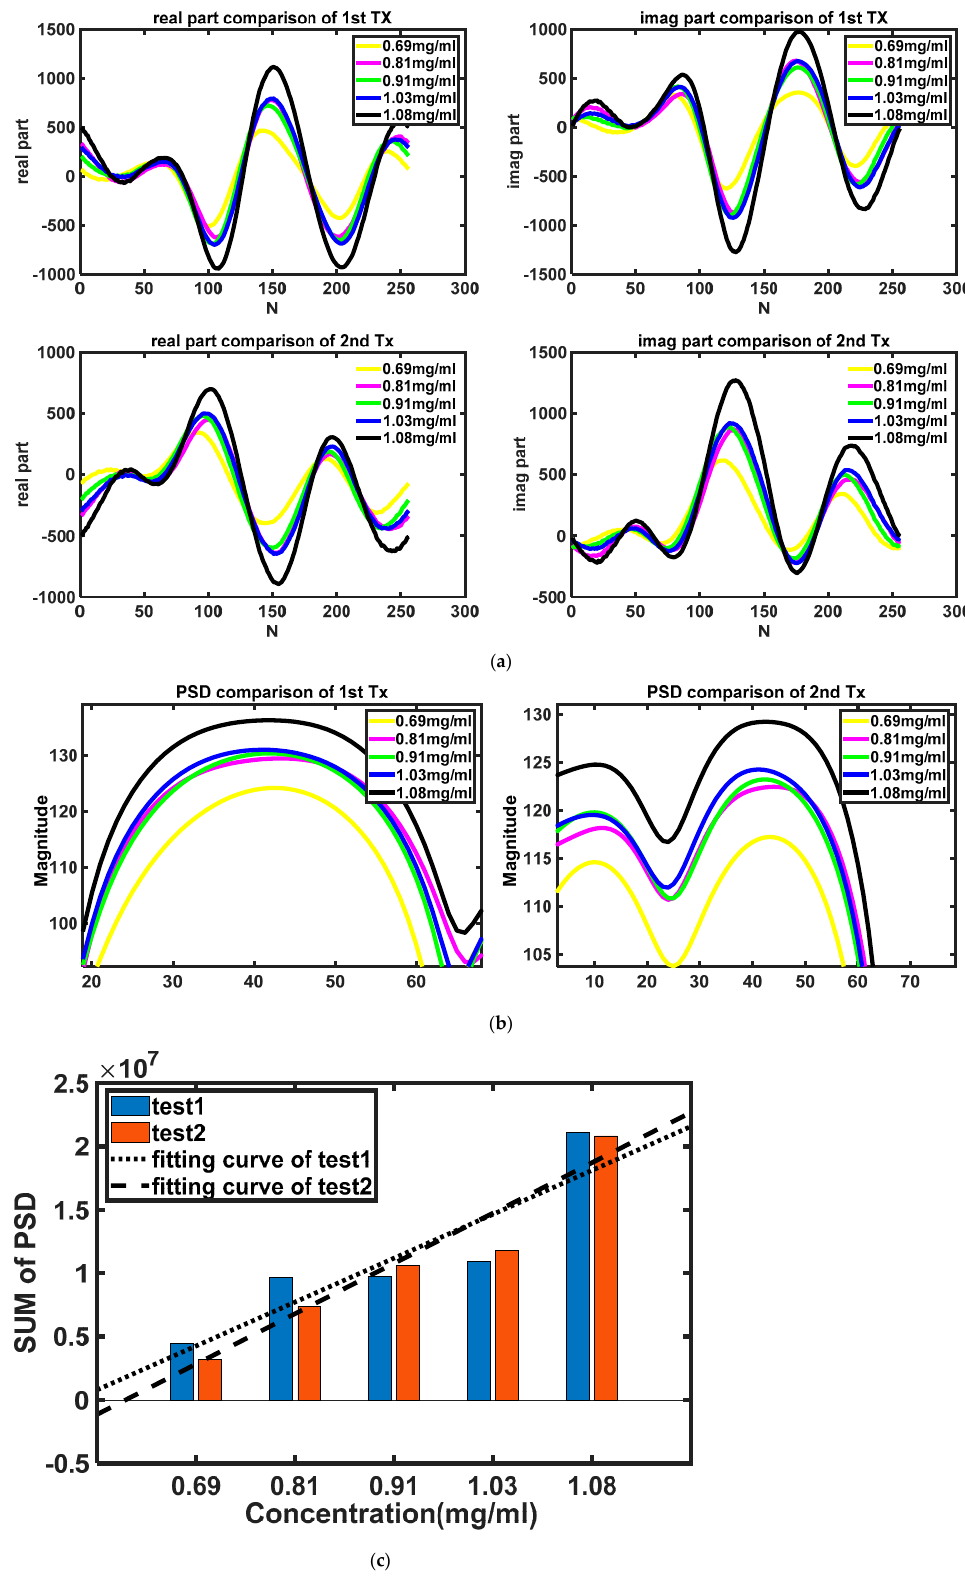
Figure 3. The result of the measurement: ( a ) time–domain signal of different concentrations and different TX; ( b ) PSD result of different concentrations in low–frequency part; ( c ) sum of PSD under different environments.